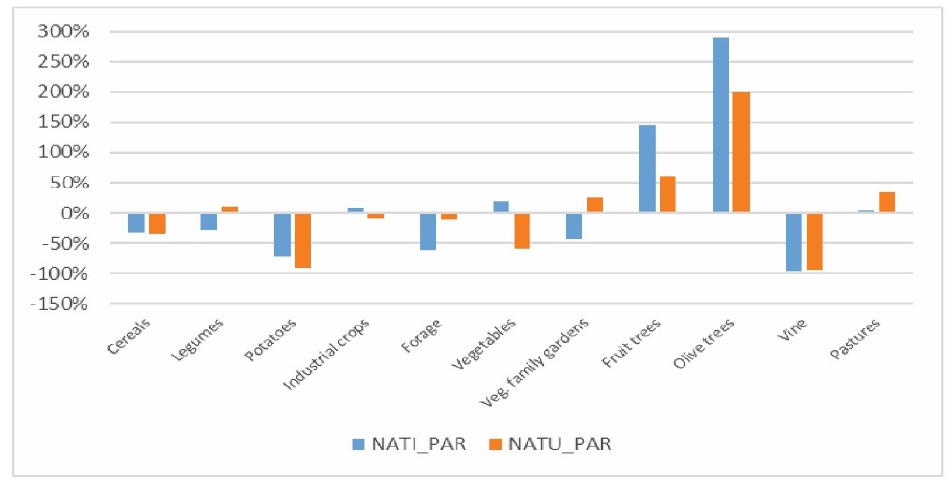
Figure 3. SNP-variation in UAA between 1989 and 2009. Source: Drawn up by the authors using data provided by the 1989 and 2009 Agrarian Censuses, Ministry of Agriculture.